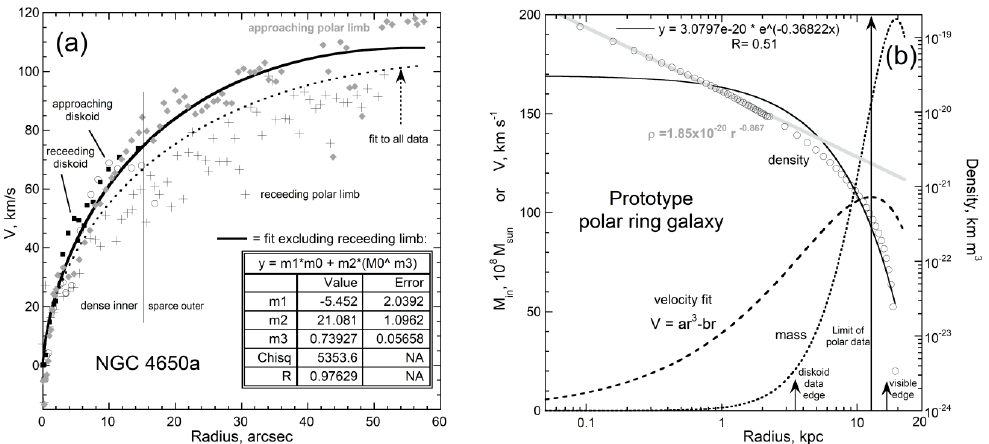
Figure 8. The prototype polar ring galaxy NGC 4650a. RC raw data from Iodice et al. [80] are similar to previous reports. ( a ) Comparison of RC data from different sectors and fits; see text. ( b ) The fit that excluded the uncertain dataset to provide M in /(10 8 M Sun ) and ρ .